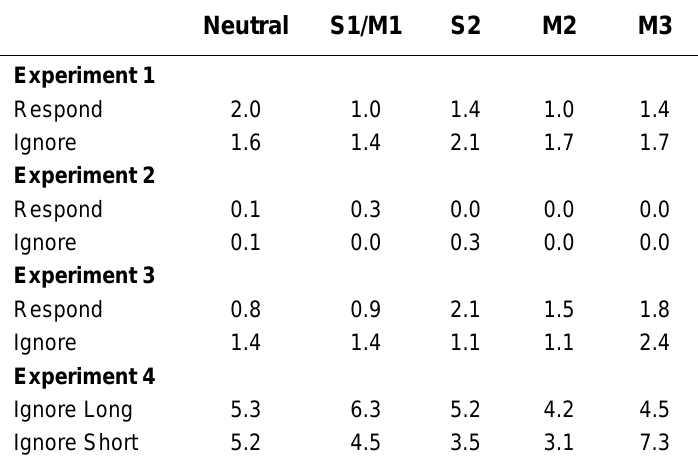
Error Rates (in %) for Localization Responses to